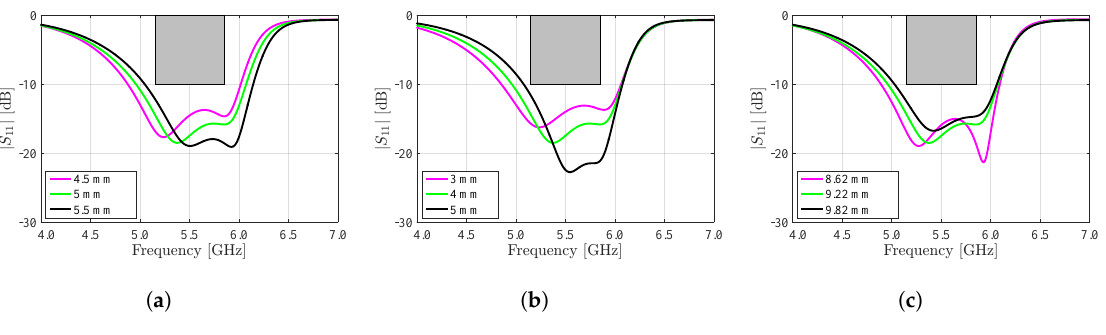
Figure 8. Influence of coupling and feed position on the magnitude of the reflection coefficient | S 1,1 | of the antenna. ( a ) Influence of slot width W s ; ( b ) Influence of electrotextile strip width W es ; ( c ) Influence of feed position D f